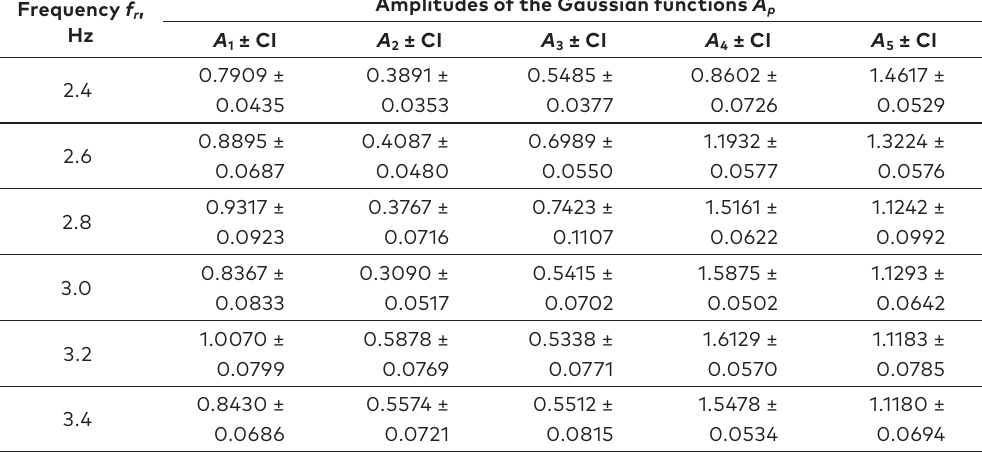
Table 10. Examples of A p mean values and 95% confidence intervals (CI) determined for one heel-strike pattern runner in frequency range